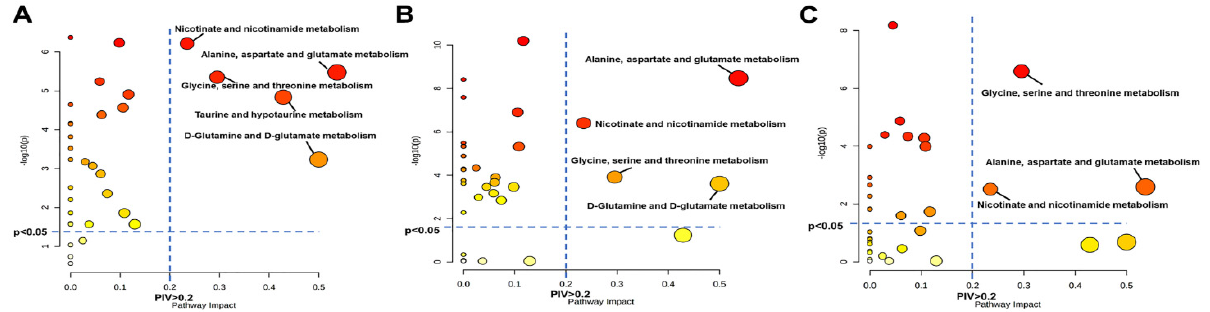
Figure 6. Significantly disturbed metabolic pathways identified from pathway analyses based on serum levels of metabolites. ( A ) aVMC vs. CON-w2; ( B ) cVMC vs. CON-w6; ( C ) DCM vs. CON-w24. Pathway impact values (PIVs) were calculated from pathway topology analysis, and p values were computed from metabolite set enrichment analysis. Significantly disturbed metabolic pathways were identified with pathway impact values > 0.2 and p values < 0.05, using the Pathway Analysis module provided by MetaboAnalyst 5.0 webserver.